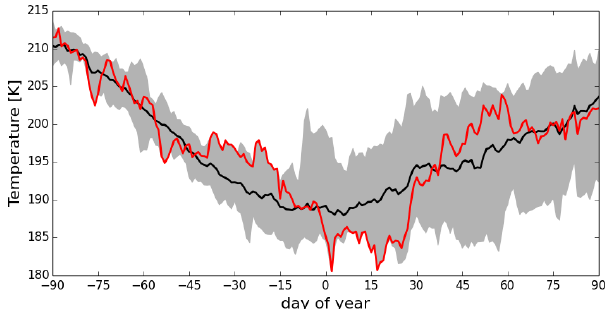
Figure 1. Minimum ECMWF temperature, T min (K), at a poten- Fig. 1: Minimum ECMWF temperature, T min [K], at a potential temperature of 500K inside the tial temperature of 500K inside the area where the equivalent lati- area where the equivalent latitude (EQL) is greater than 70 ◦ , corresponding to the area inside the tude (EQL) is greater than 70 ◦ , corresponding to the area inside the Arctic polar vortex, as function of days of year (0 refers to 1 January). The black solid line shows Arctic polar vortex, as function of days of year (0 refers to 1 Jan- the mean value for years 2001 to 2012. The red line is the T min temporal evolution from 1 October uary). The black solid line shows the mean value for years 2001 to 2009to31March2010. Theshadedareaencompassestheminimum/maximumT min between2001 2012. The red line is the T min temporal evolution from 1 October and 2011. 2009 to 31 March 2010. The shaded area encompasses the mini- Figure 2. Geographical distributions of ozone observations from mum/maximum T min between 2001 and 2011. SMILES and Odin/SMR on 2010-01-31. Fig. 2: Geographical distributions of ozone observations from SMILES and Odin/SMR on 2010-01- 31. 18